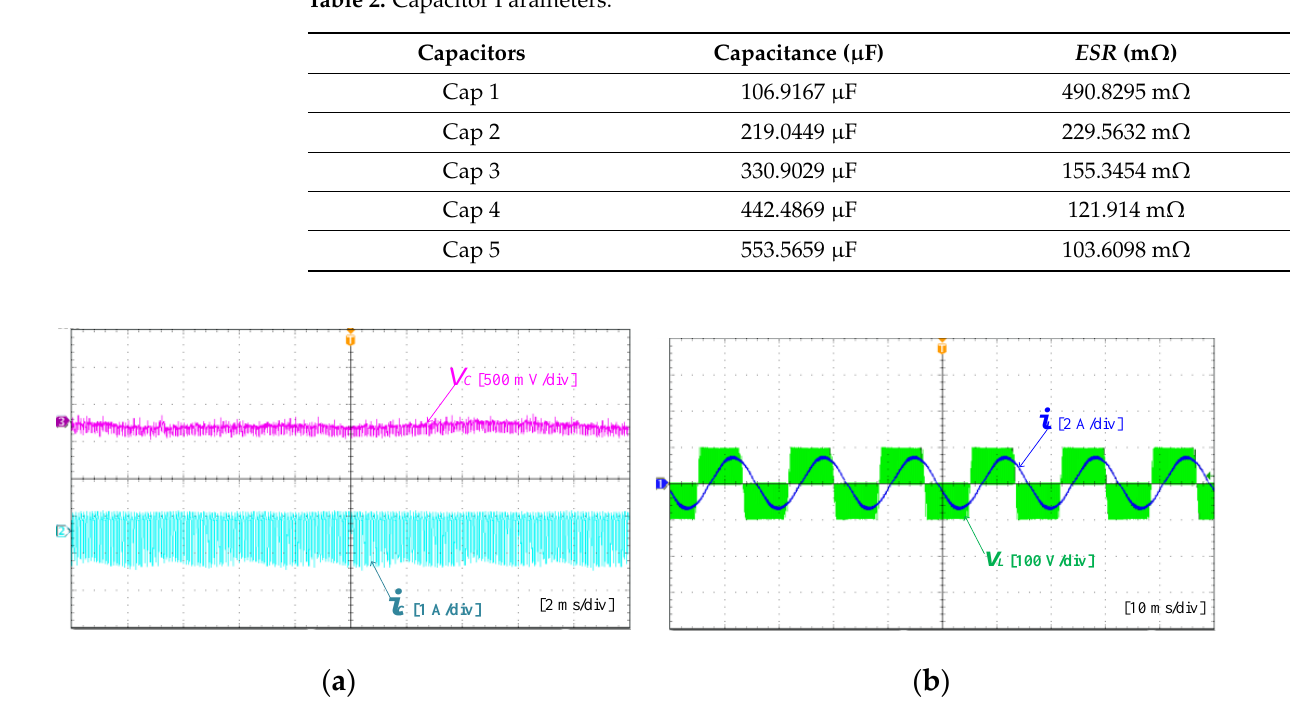
Figure 4. Experimental waveform of three-phase inverters: ( a ) capacitor signals and ( b ) load signals. Table 1. Experiment Specifications.